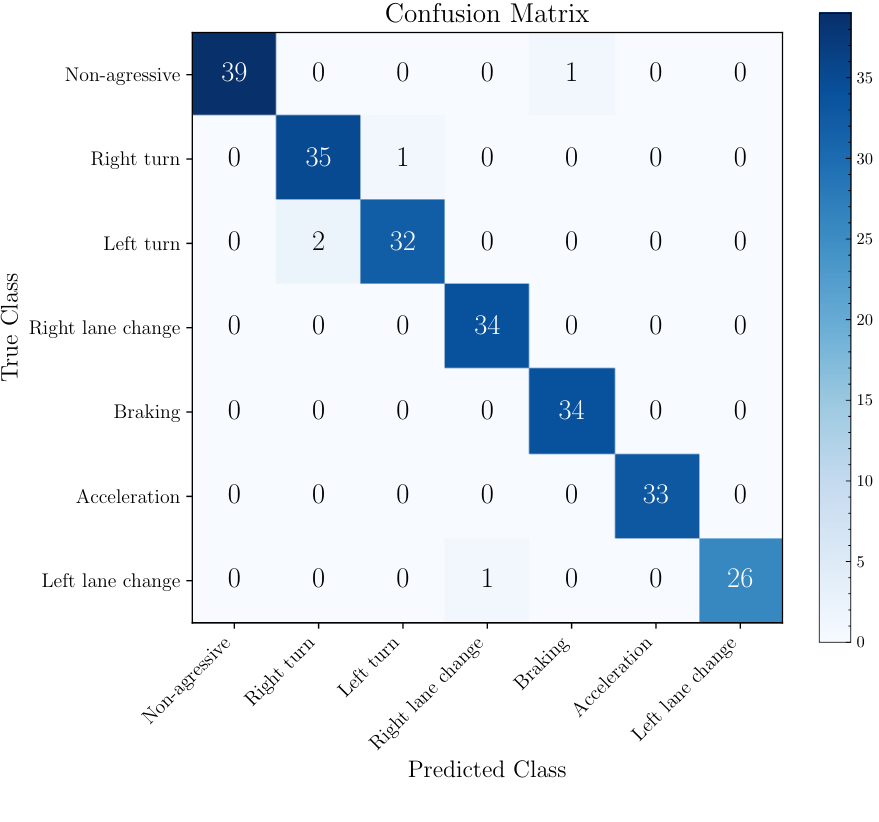
Figure 10. Confusion matrix of the 2D-AlexNet model (best model trained and validated with 10-fold cross-validation). Confusion matrix obtained from the evaluation of the entire